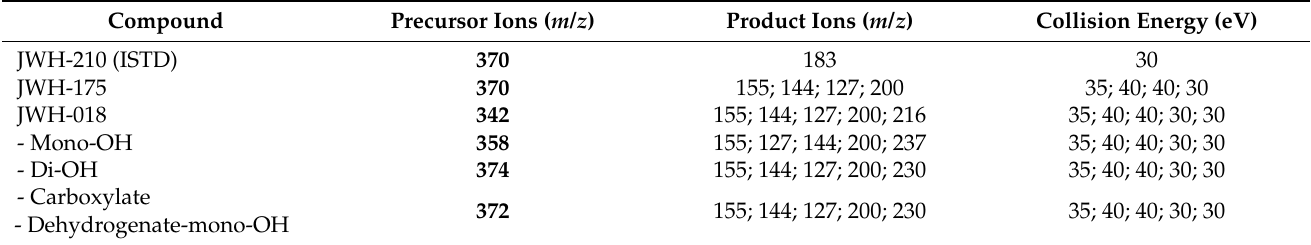
Table 3. Mass spectra parameters for metabolism studies including precursor and product ions and relative collision energies for